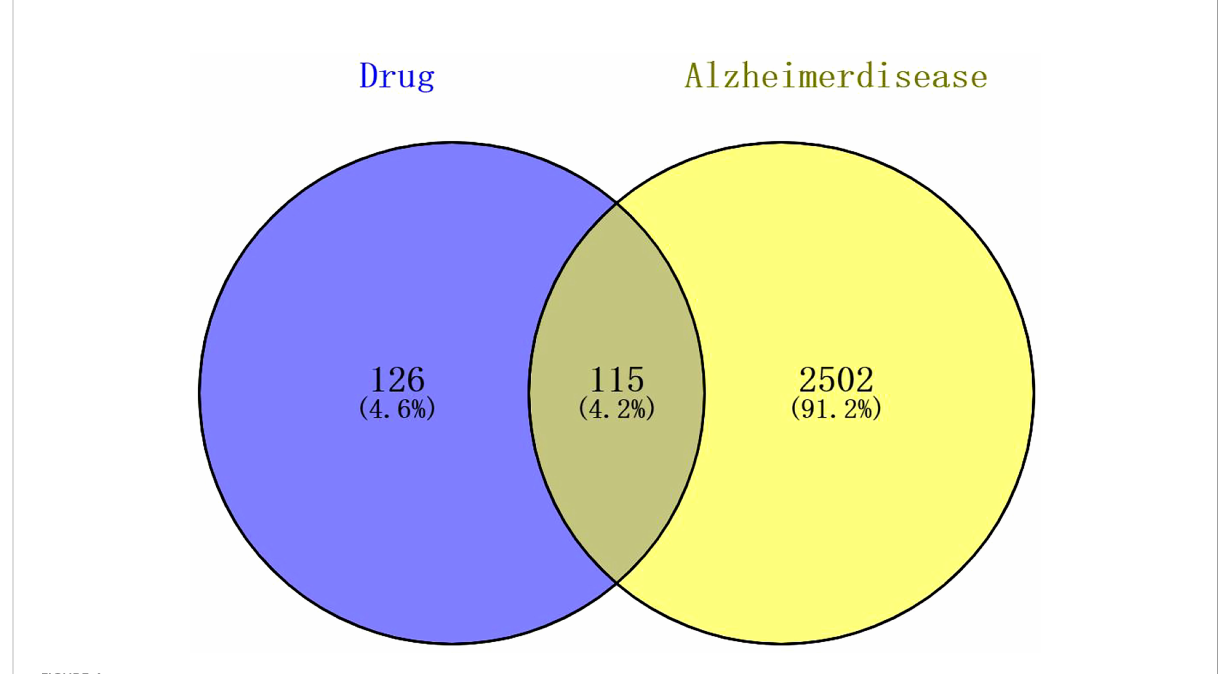
FIGURE 4 The Venn diagram of compound 4m and AD